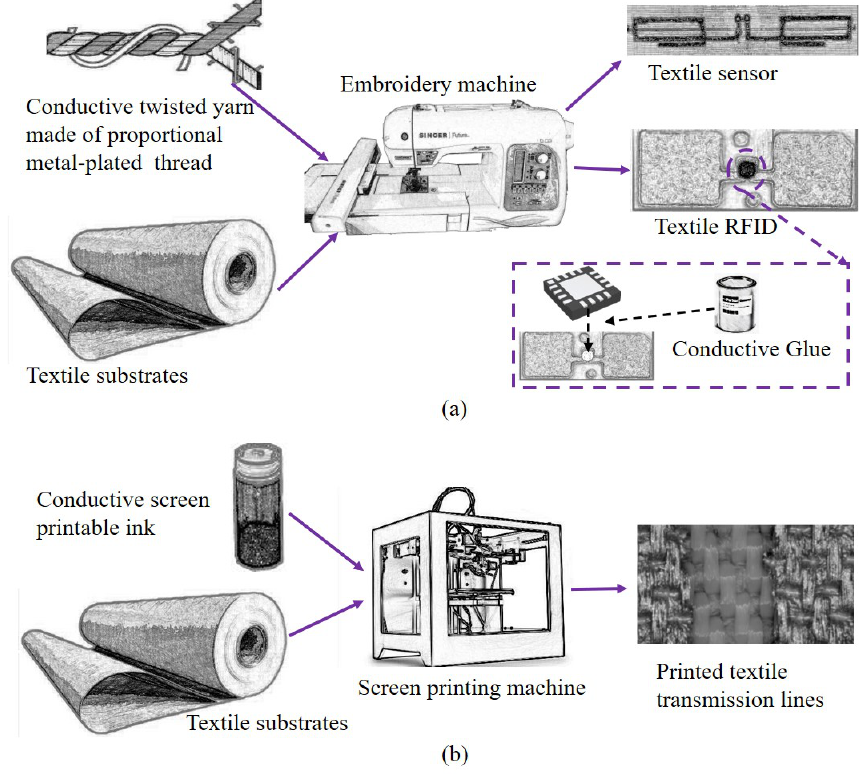
Figure 2. Two typical electro-textile techniques. ( a ) Embroidery technique using conductive yarns, ( b ) screen printing technique using special conductive